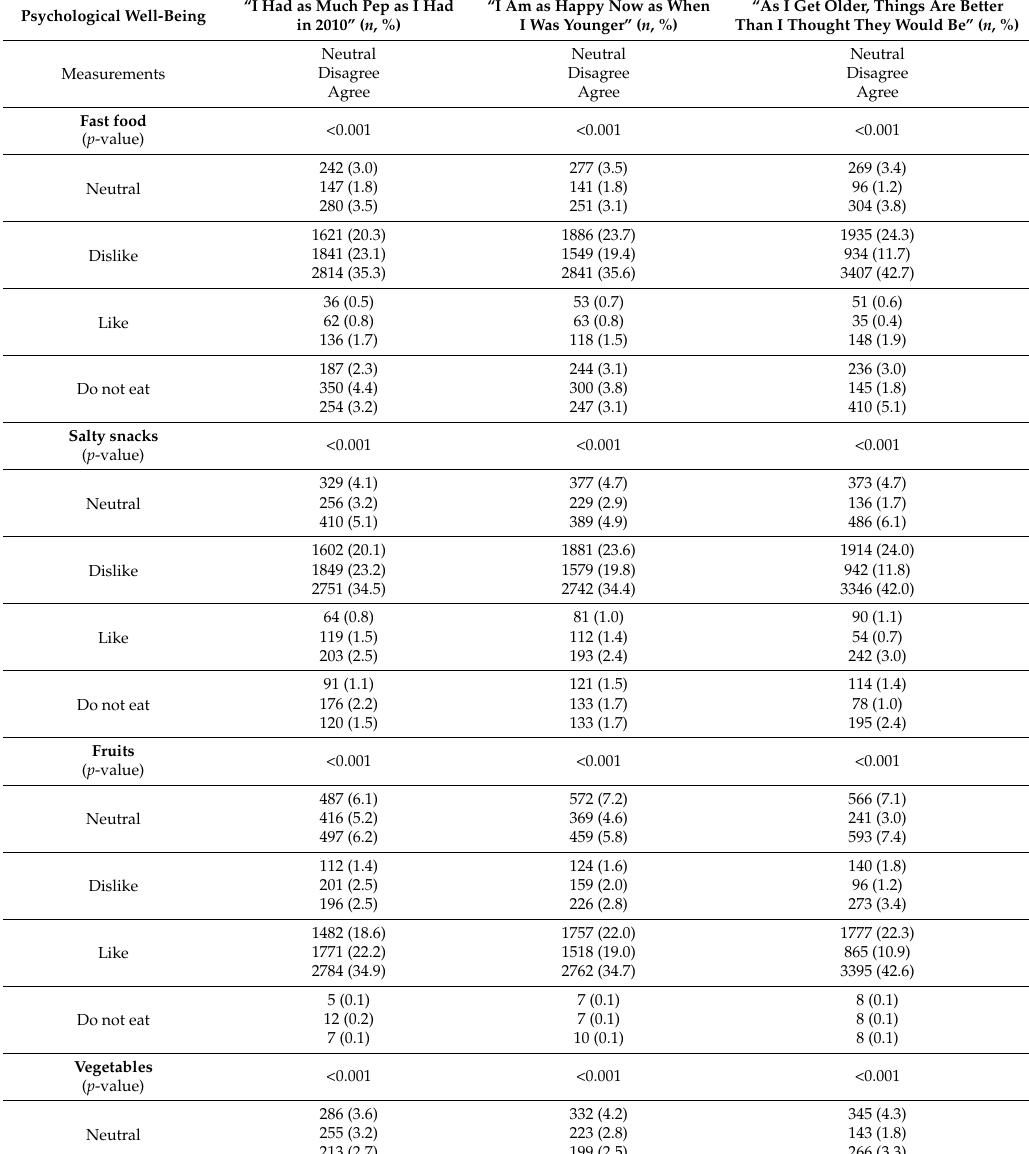
Table 2. Prevalence rates and crude examinations of food preferences and psychological well-being measurements ( n = 7970); Data: China Health and Nutrition Survey,